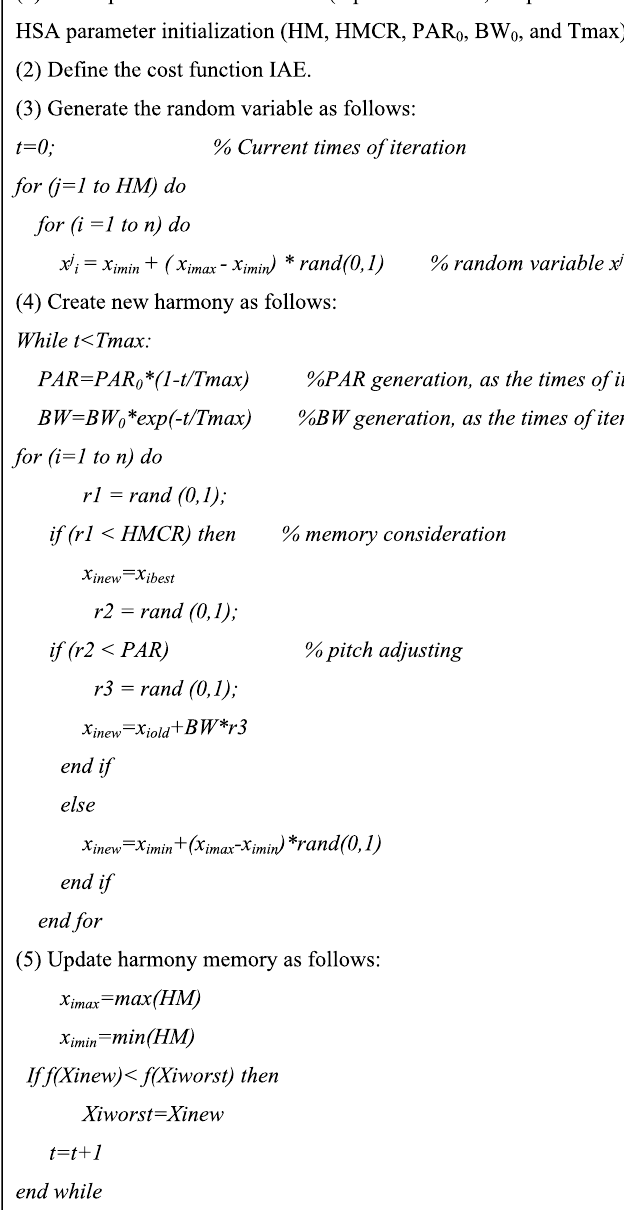
On the basis of the Matlab command, the zero points (z), pole points (p) and gain (k) of the system are: